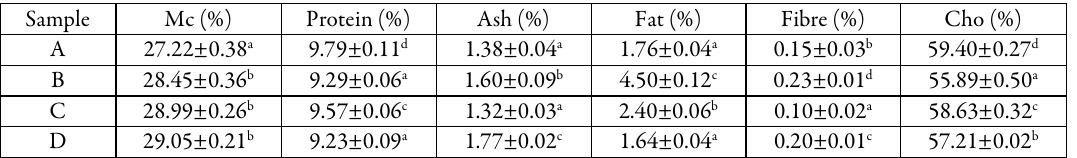
Table1. Proximate composition of bread samples